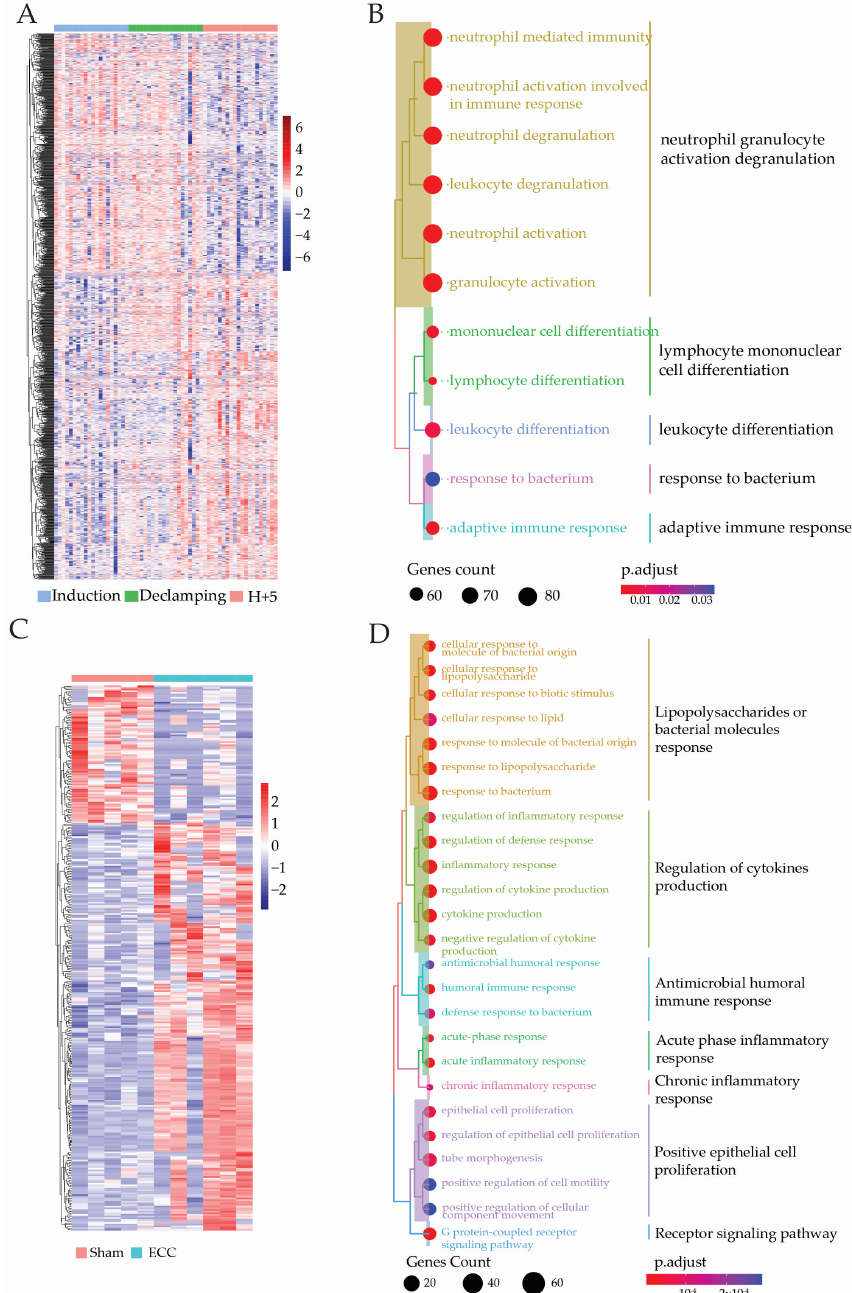
Figure 3. Pathway enrichment analysis from transcriptome analyses from rats’ and patients’ PBMC. The transcriptome analyses were made from PBMC from rats that underwent the ECC procedure (ECC group) or not (sham group). Differentially expressed genes were selected by their fold change of expression (log2Ratio(ECC/Sham) > 2 or log2Ratio(ECC/Sham) < 2), as seen in the heatmap ( A ). The biological process enrichment has been processed on the selected genes and represented in the function of the GeneRatio and count ( B ). The transcriptome analyses were achieved on human PBMC collected before, during, and after the ECC procedure in cardiac surgery. The top 8% of differentially expressed genes were selected by their rank given by the Hotelling T 2 score calculated with the time course analysis. The selected genes were clustered in the heatmap ( C ). The biological process enrichment has been processed on the selected genes and is represented in the function of the GeneRatio and count ( D